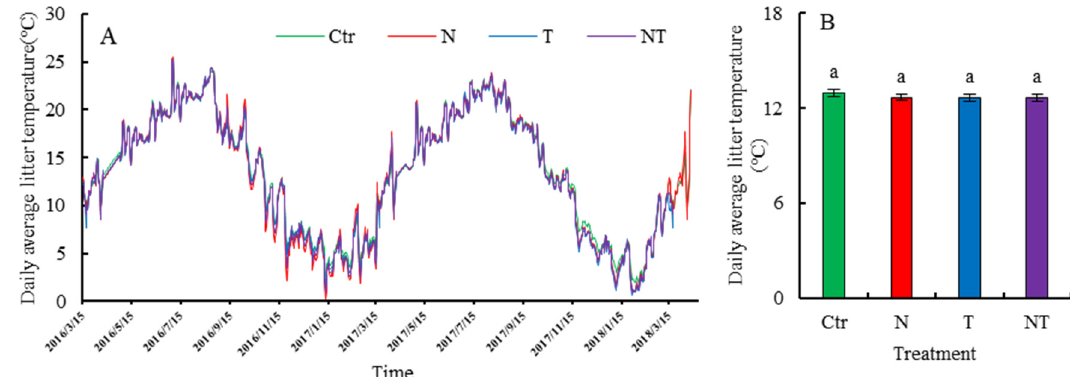
Figure A1. Dynamics of daily average temperature of leaf litter in the litterbags in the field during the two-year experiment from 15 March 2016 to 20 March 2018 ( A ). Different lowercase letters in panel ( B ) denote significant differences between treatments based on linear mixed-effects models (Multiple comparisons with Bonferroni adjustment method, p < 0.05). Ctr: without nitrogen deposition or throughfall reduction, N: nitrogen deposition (150 kg · N · ha − 1 · y − 1 ), T: throughfall reduction (10%), NT: nitrogen deposition (150 kg · N · ha − 1 · y − 1 ) and throughfall reduction (10%).